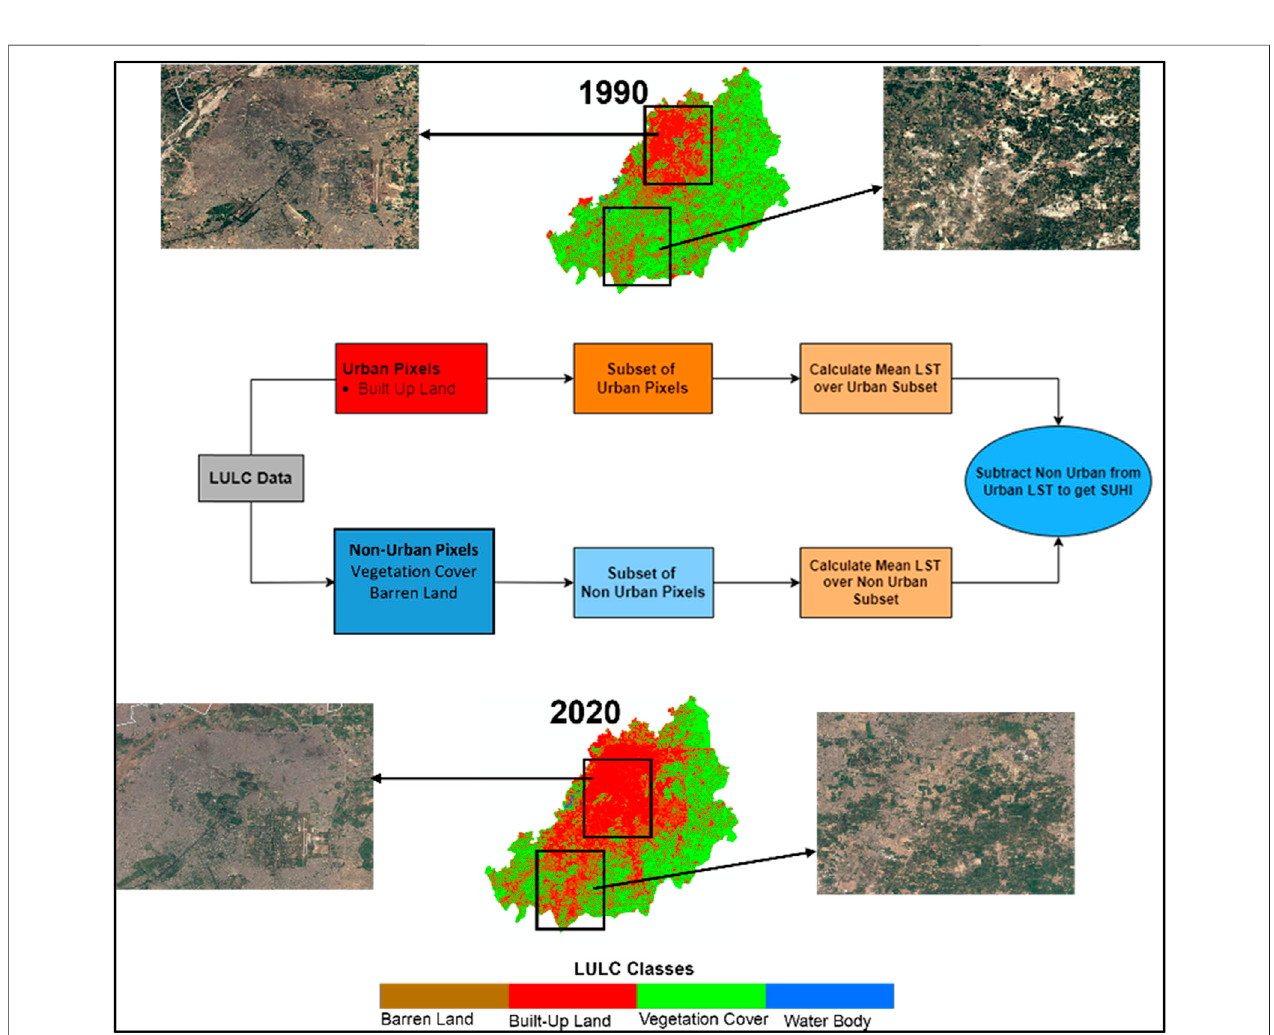
FIGURE 2 | Steps followed using Chakraborty and Lee (2019) methodology for calculation of SUHI.